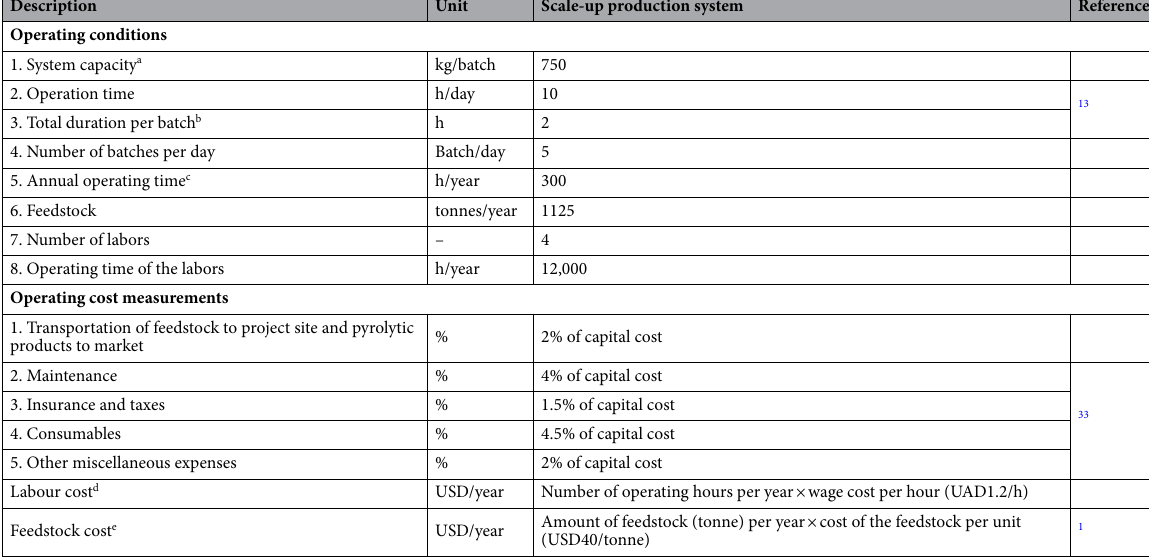
Table 3. Description of operating conditions of scale-up microwave pyrolysis production system. [ a Capacity for scale-up system, b Total duration of the batch includes preparing the sample, reaction time, cooling down, and collect the products, c Annual operating time considering, d Based on https:// tradi ngeco nomics. com/ egypt/ minim um- wages, e FAO,